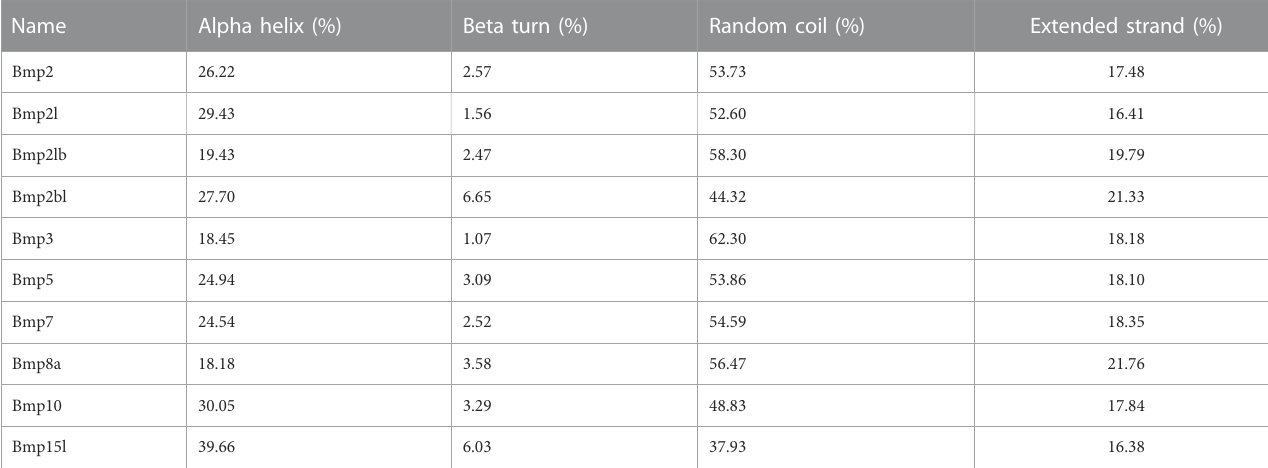
TABLE 2 The secondary structure prediction of BMP proteins in P . sinensis